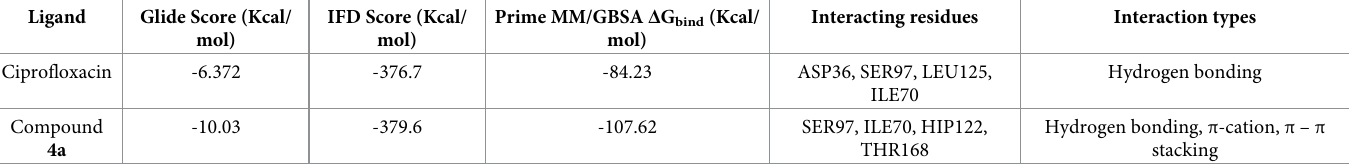
Table 3. Parameters for induced fit docking and Prime/MM-GBSA simulation of test ligands at binding pocket of